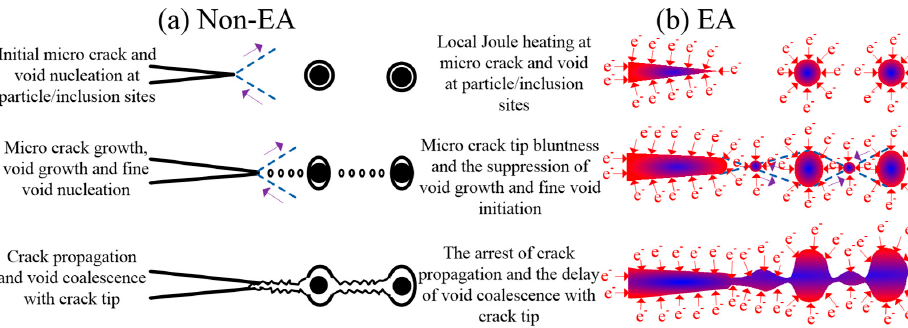
Figure 10. Expected mechanism of crack propagation, void nucleation, growth and coalescence: ( a ) non-EA and ( b ) EA configurations.